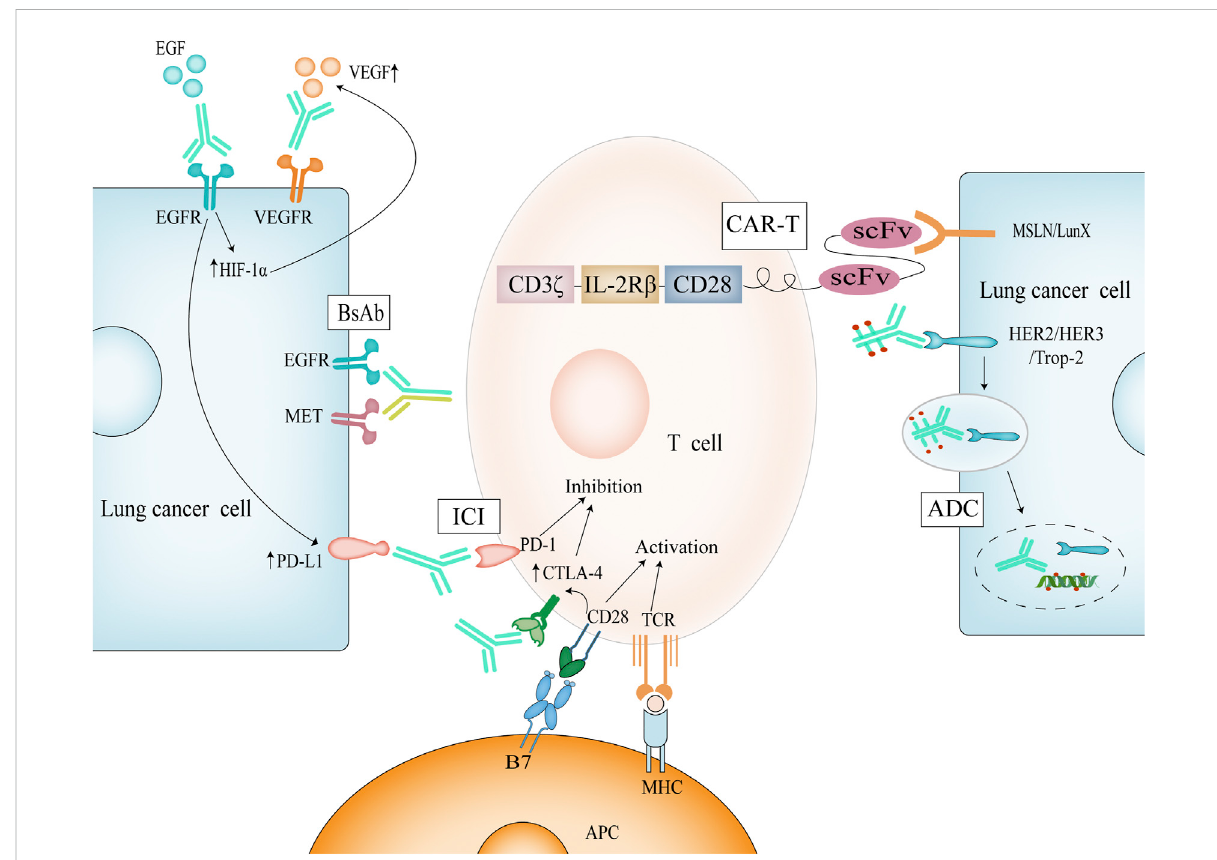
FIGURE 1 MechanismofimmunotherapyforNSCLC.DualsignalingactivationofTcellscausesupregulationofCTLA-4,whichcompeteswithB7andthus regulates T cell activation. ICI can perform immune enhancement by blocking these targets; Activation of EGFR causes upregulation of HIF-1 α and thus of VEGF. Simultaneous inhibition of EGFR and VEGF has a synergistic